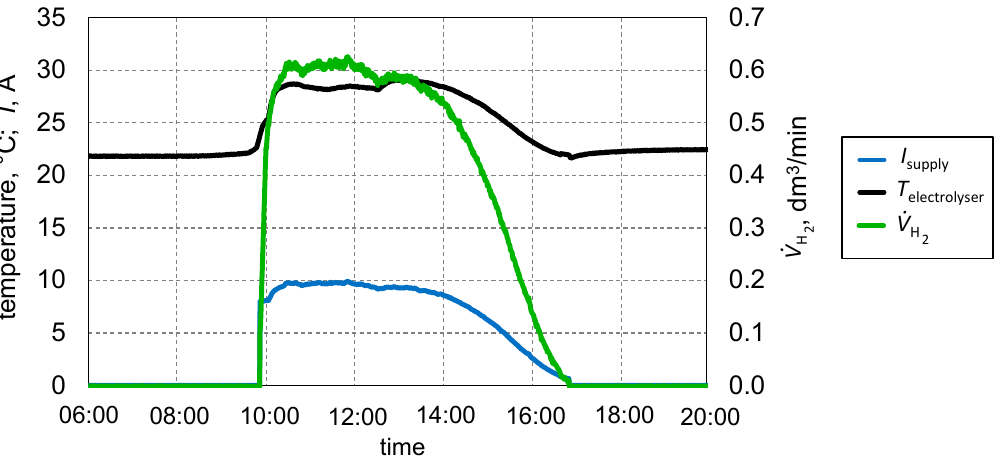
Figure 8. The current supplying the H 2 generator, temperature of the electrolyzer, and hydrogen flow rate during measurements.